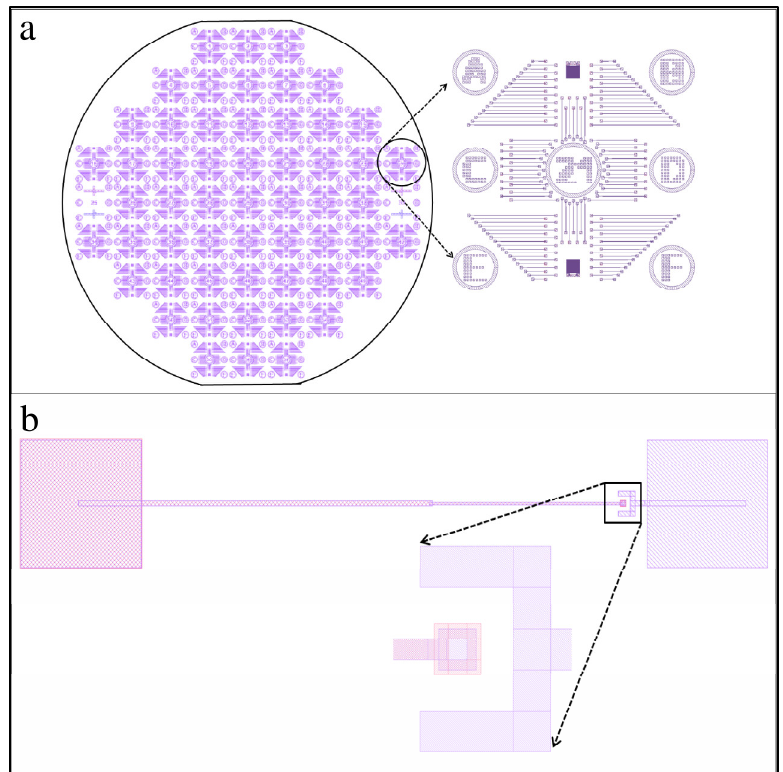
Figure 6. Mask 2 design pattern. ( a ) Fully patterned wafer with 57 identical units and a zoomed-in view of a single 1 cm unit. Notice each 1 cm unit is numbered (this one is unit 21) and has regions A-F labeled for easy record keeping.; and ( b ) A single trench, well, and tip structure with a zoomed-in view of the tip-well region with a graphene membrane bonding pad to the right of the tip-well structure.